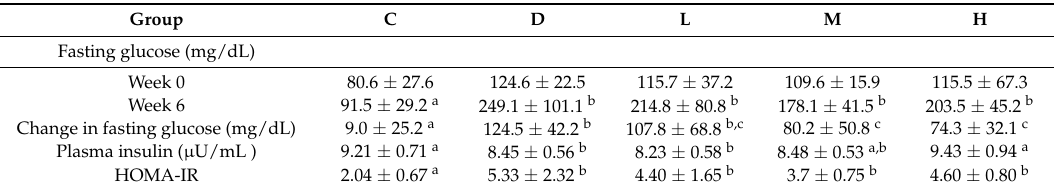
Table 3. Fasting glucose, plasma insulin, homeostasis model assessment for insulin resistance (HOMA-IR) after the six-week melatonin intervention.